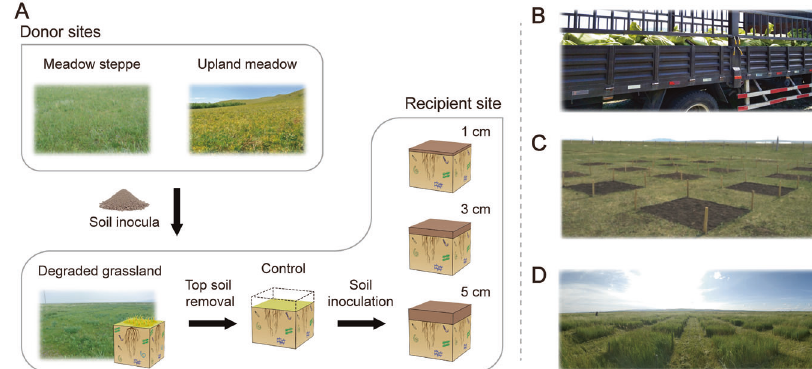
Fig. 1 Graphical illustration of the experimental design. A Three replicate meadow steppes and upland meadows were selected as donor sites. At each donor location, the soil of the top 10 cm was excavated, homogenized and transported to the degraded grassland. The experiment was set up with three fully replicated blocks. In each block, one plot without inoculation was also established. We established 19 experimental plots of 2 × 2 m 2 (2 soil types × 3 replicate sites × 3 inoculum amounts + control) in each block and a total of 57 plots. B The transfer of soil inoculum in 2018 to the fi eld; C the experimental fi eld site after inoculation in 2018; D and three years later, in